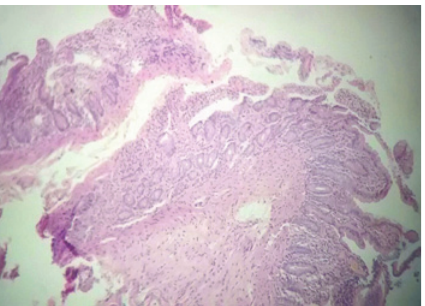
Figure 3: Duodenal mucosa shows preserved cryptovillus architec- tureandmoderatelymphocyticinfiltrateinthelaminapropriaalong with a few